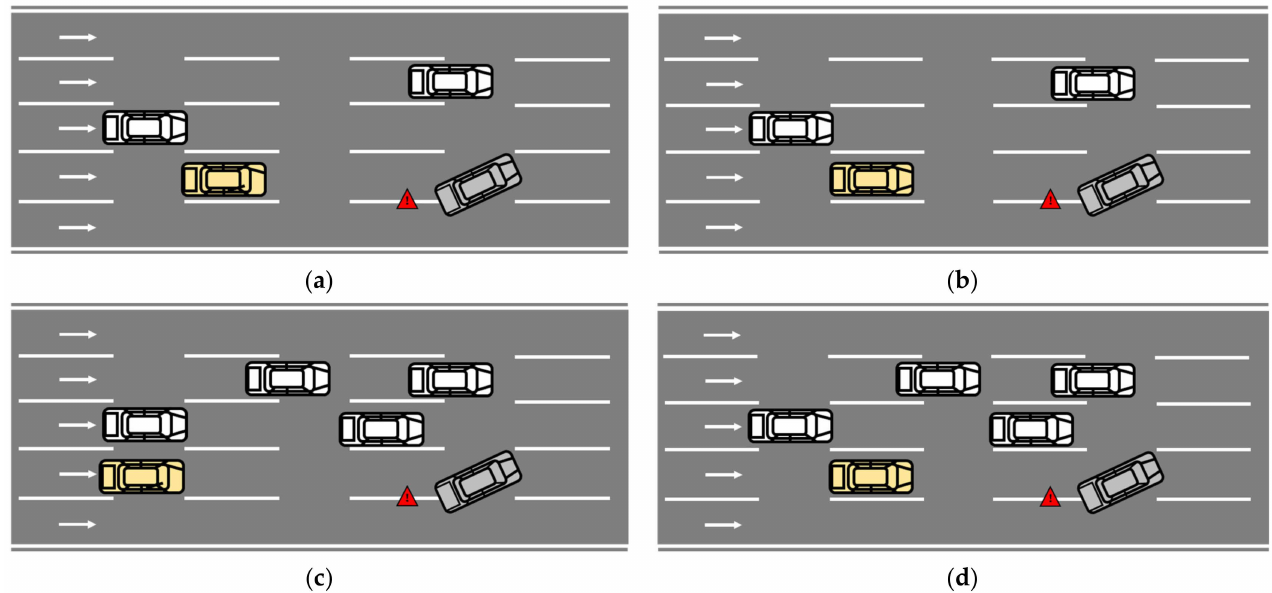
Figure 4. Take-over scenarios with different urgency. ( a ) Scenario 1; ( b ) Scenario 2; ( c ) Scenario 3; ( d ) Scenario 4. White vehicles are manual human driving vehicles; yellow vehicle is automated driving vehicle; gray vehicle is accident